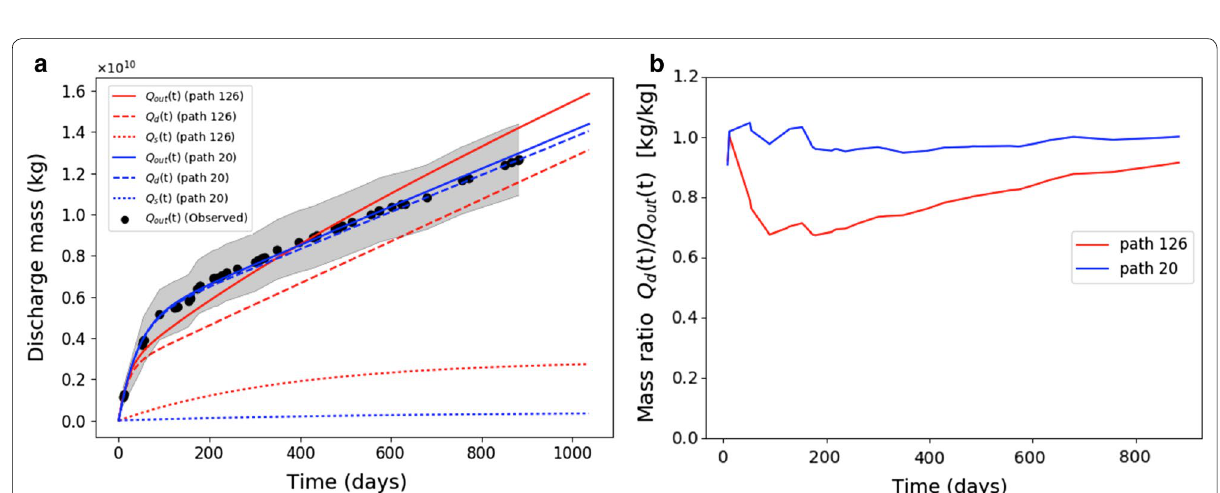
Fig. 8 a Fitting results for discharge mass by combination of two components: (1) best-fit function for the corrected GNSS time series (as shown in Fig. 5) and (2) best-fit function for the deflation volume time series of the shallow source: Δ V s ( t ) (as shown in Fig. 4). Red and blue colors correspond to satellite path of 126 and 20, respectively. Solid, dashed and dotted lines indicate synthetic Q out ( t ) ( indicates range of estimated errors of the discharge mass. b Temporal change in the mass ratio of Q d ( t ) to Q out ( t ). Red and blue colors correspond to satellite path of 126 and 20, respectively. Value of more than 1.0 is due to fitting error